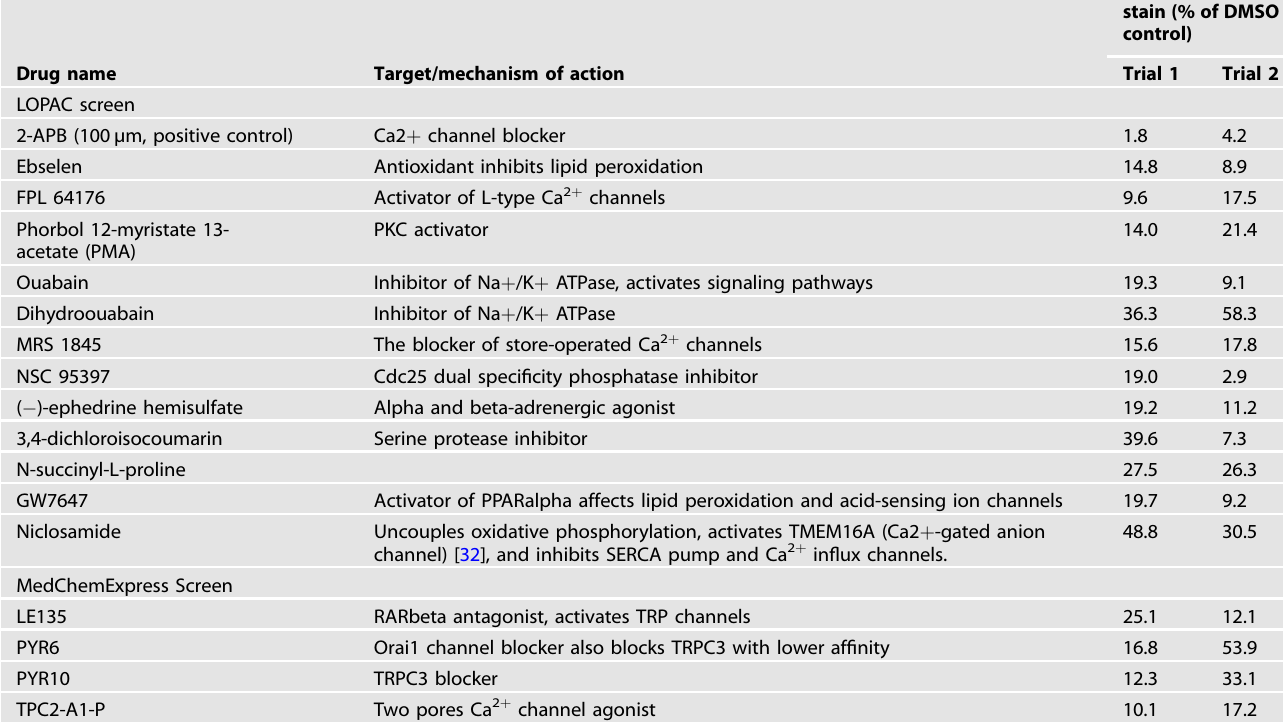
Table 1. Summary of hit compounds protecting cells from light-triggered MLKL